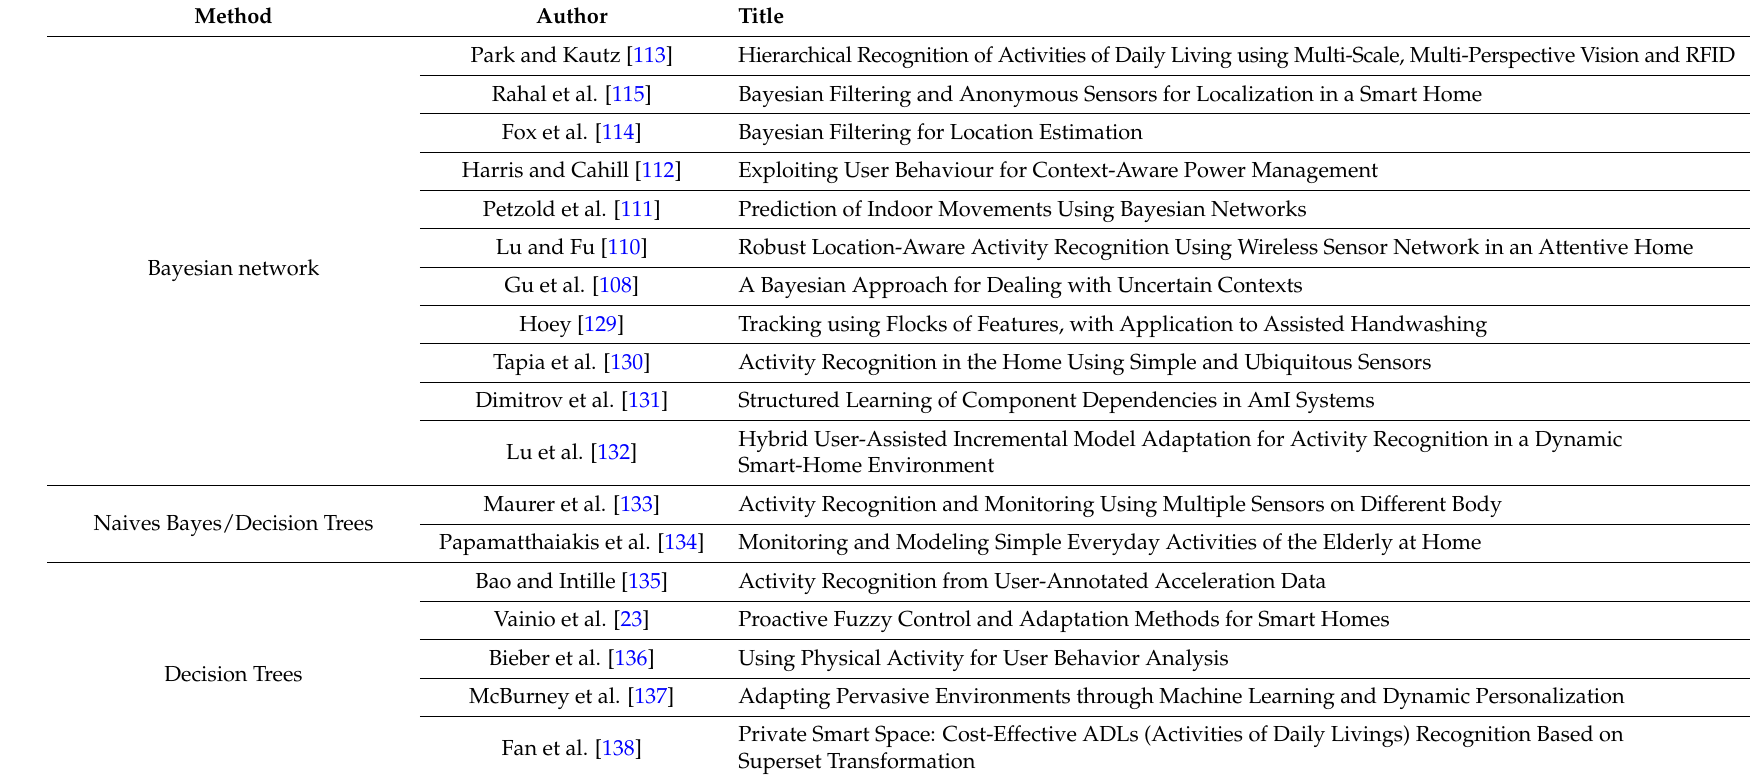
Table 1. Most Implemented Methods in Smart